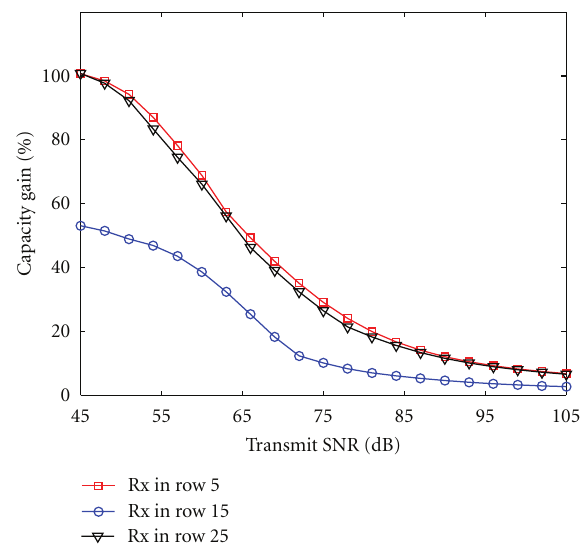
Figure 3: Ergodic capacities with di ff erent TAS schemes at 24 Rx positions.